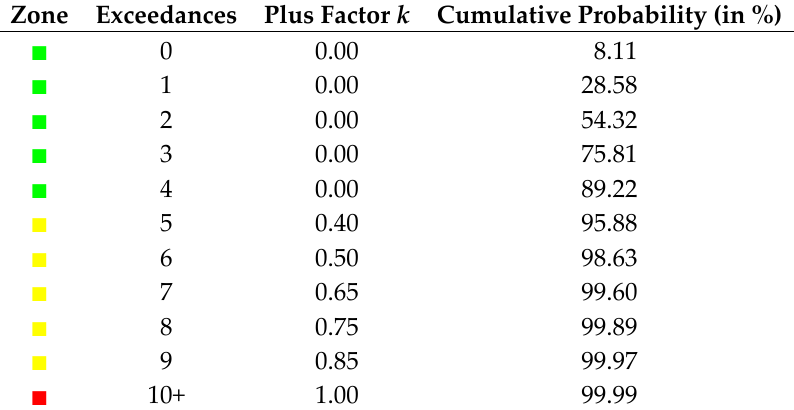
Table 1. Multiplication factor 3 + k according to Basel’s traffic-light system.